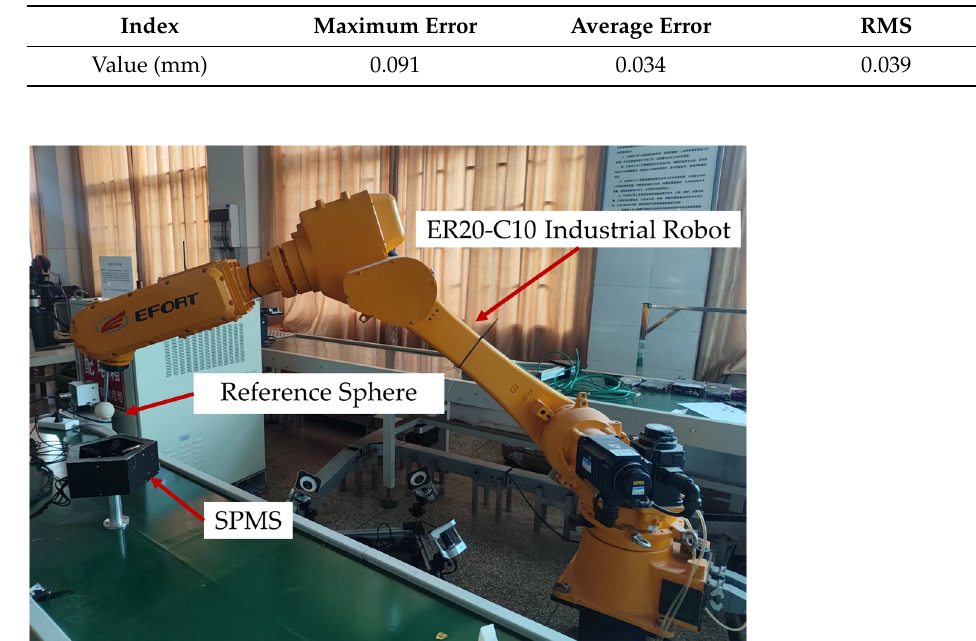
Figure 6. The measuring errors of SPMS. Table 3. The statistics information of the measuring errors.